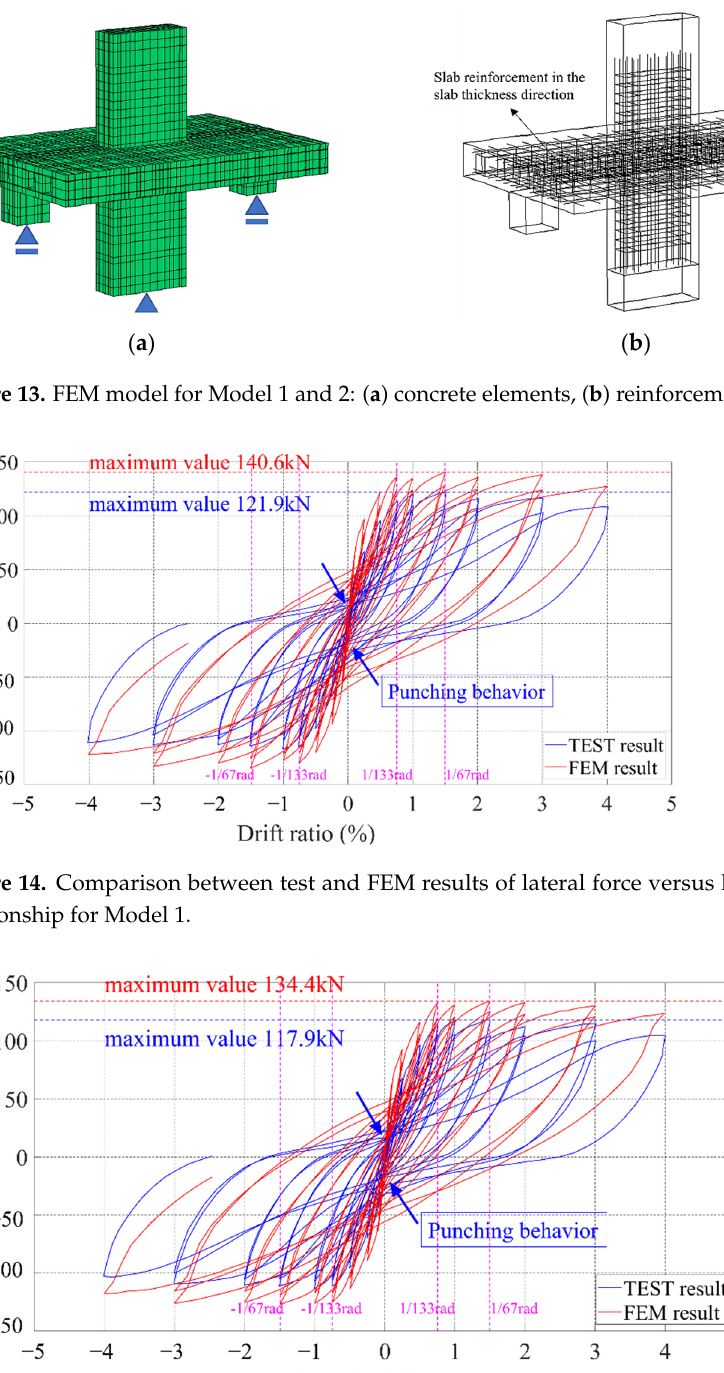
Figure 14. Comparison between test and FEM results of lateral force versus lateral drift ratio (%) relationship for Model 1. Figure 15. Comparison between test and FEM results of lateral force versus lateral drift ratio (%) relationship for Model 2.